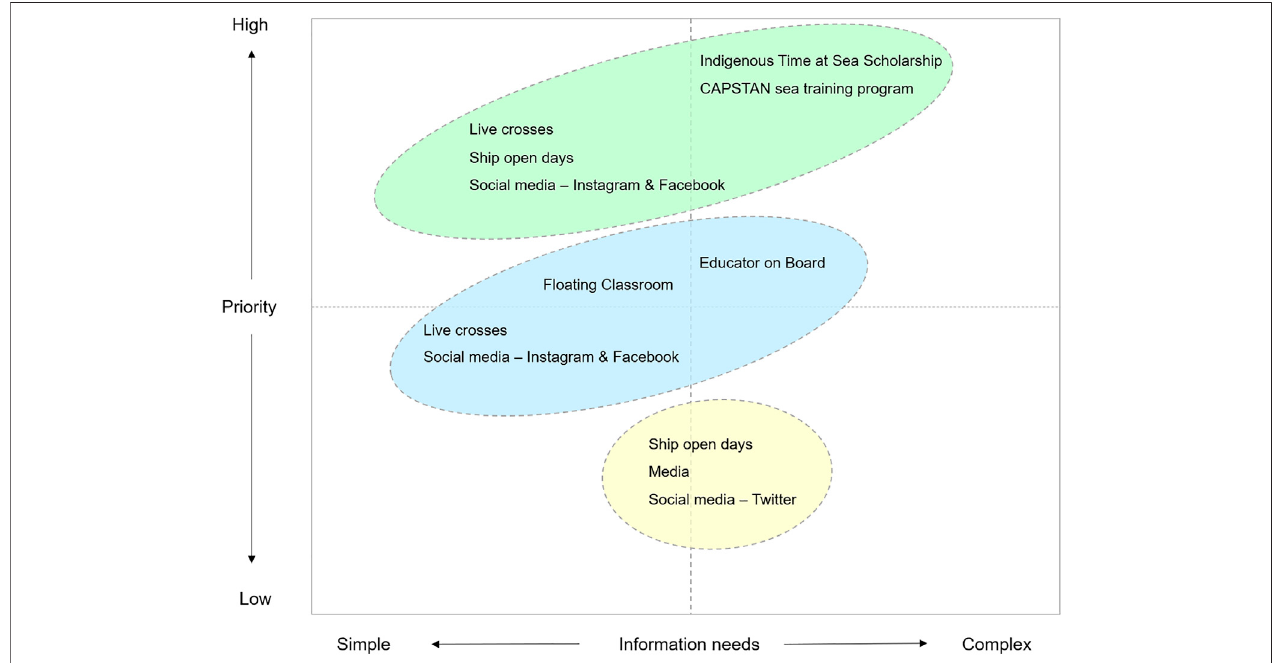
FIGURE 1 | Audience map of the MNF Outreach Program in context of target priority ( y -axis) and information needs ( x -axis). Audience segment groupings are represented by colored ellipses (green (cid:1) Purpose Seekers, blue (cid:1) Nurturers, yellow (cid:1) Lifelong Learners).